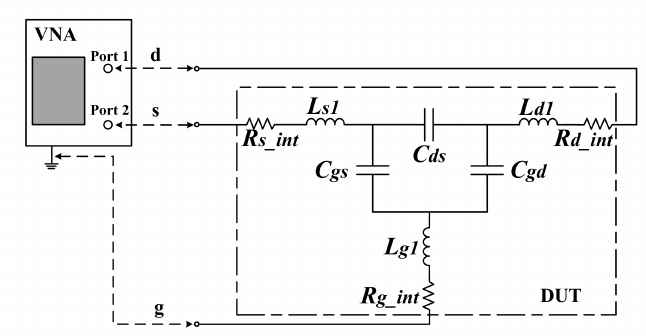
Figure 7. Equivalent circuit of MOSFET under zero applied